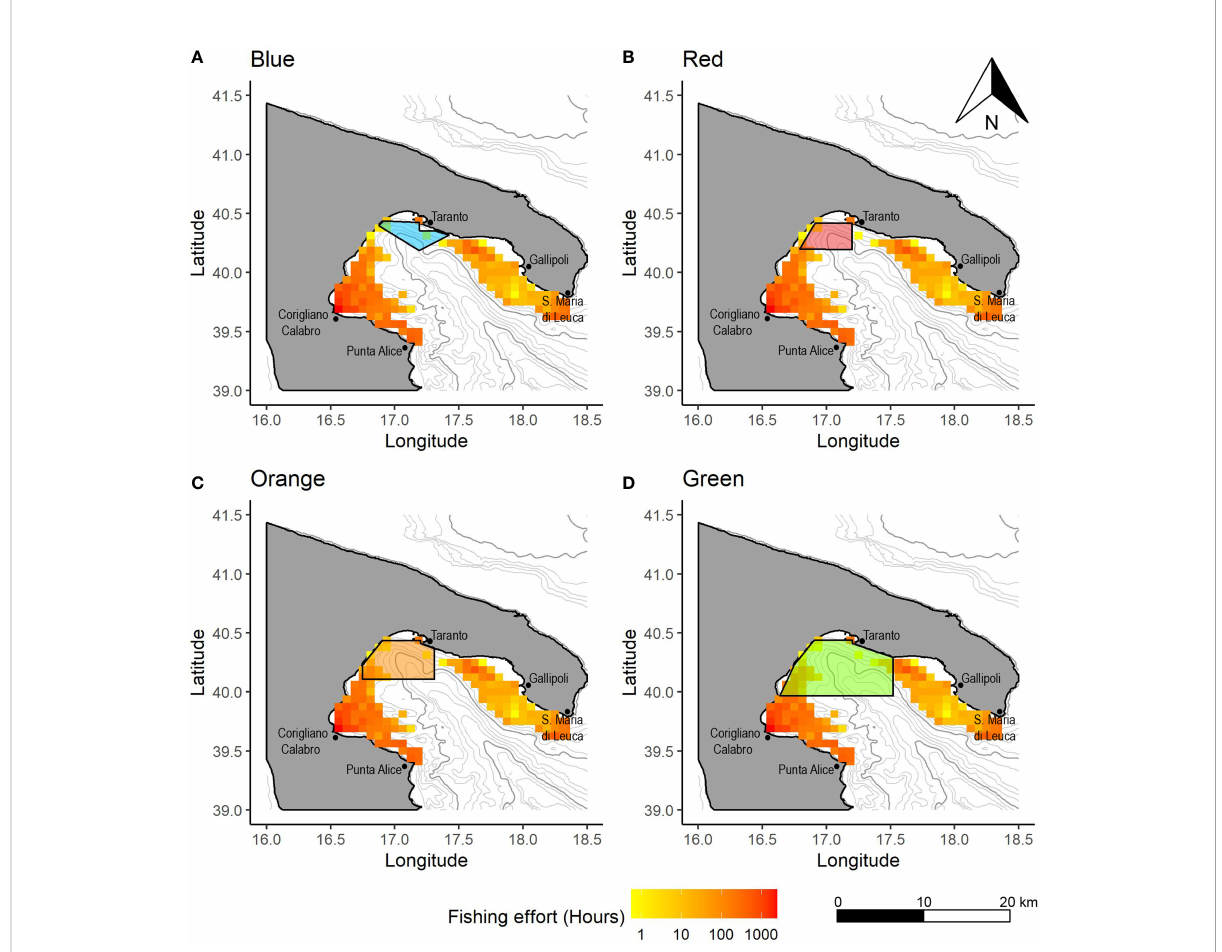
FIGURE 4 Spatial distribution of the OTB effort (in hours) by VL 12-18 showing the overlap with the (A) Blue, (B) Red, (C) Orange and (D) Green CCAs. Values in hours are calculated as yearly averages for the period